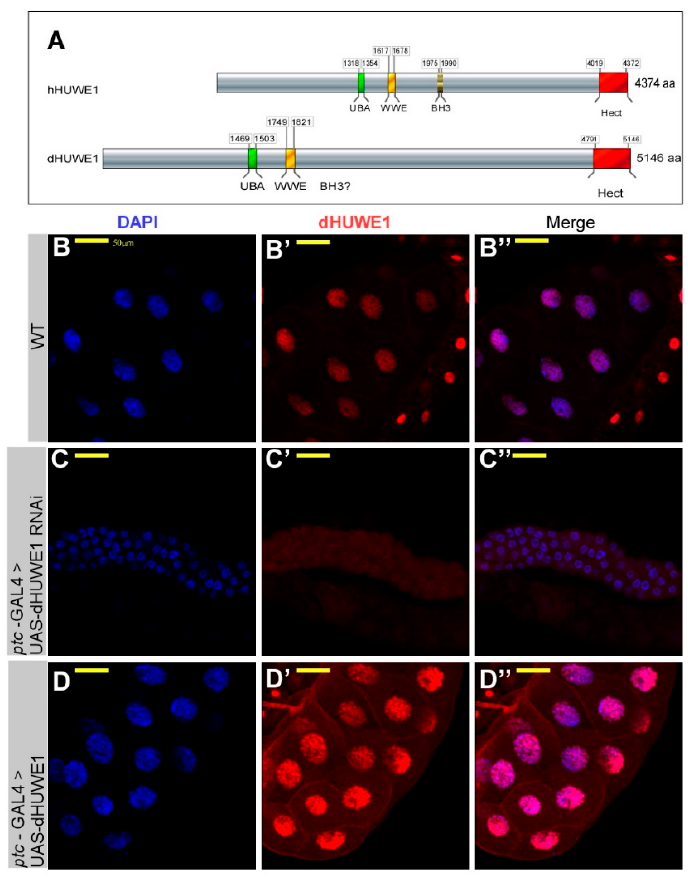
Figure 1. dHUWE1 is required for salivary gland development. ( A ) Schematic diagram of human and Drosophila dHUWE1 proteins (not to scale). UBA (green) and WWE (yellow) are ubiquitin-binding motifs. BH3; Bcl2-homology domain, and HECT domain is the catalytic core (red). ( B – D” ) Indirect immunofluorescence confocal microscopy images of wild-type and the indicated transgenic lines stained with anti-dHUWE1 antibody (red). DAPI (blue) marks DNA, and the scale bar is 50 µ m. ( B ) Endogenous levels of dHUWE1. ( C – D” ) Expression of UAS-dHUWE1-RNAi ( C , C” ) or UAS-dHUWE1 ( D , D ”) under the control of ptc -Gal4.